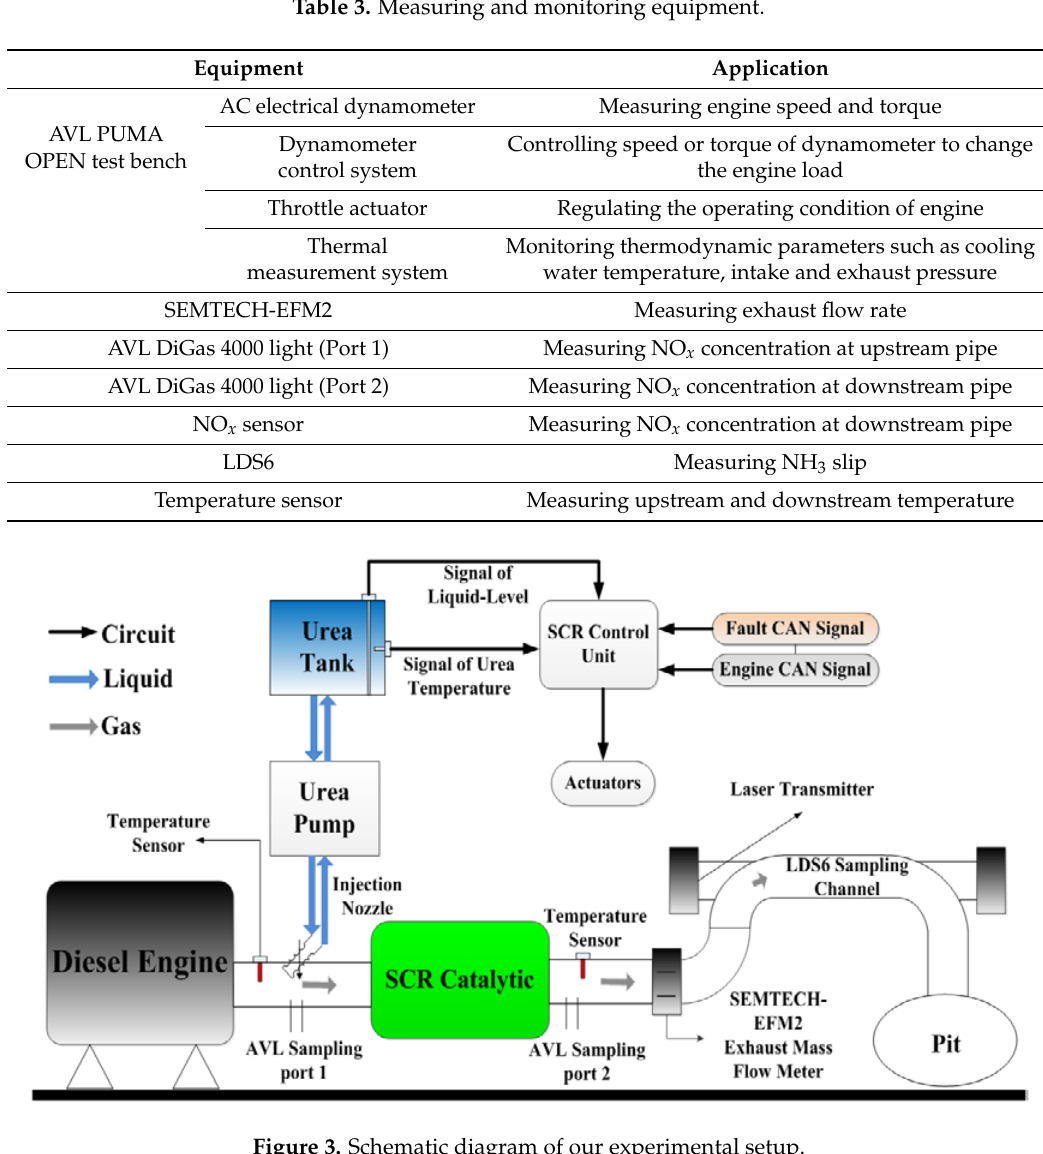
Figure 3. Schematic diagram of our experimental setup.